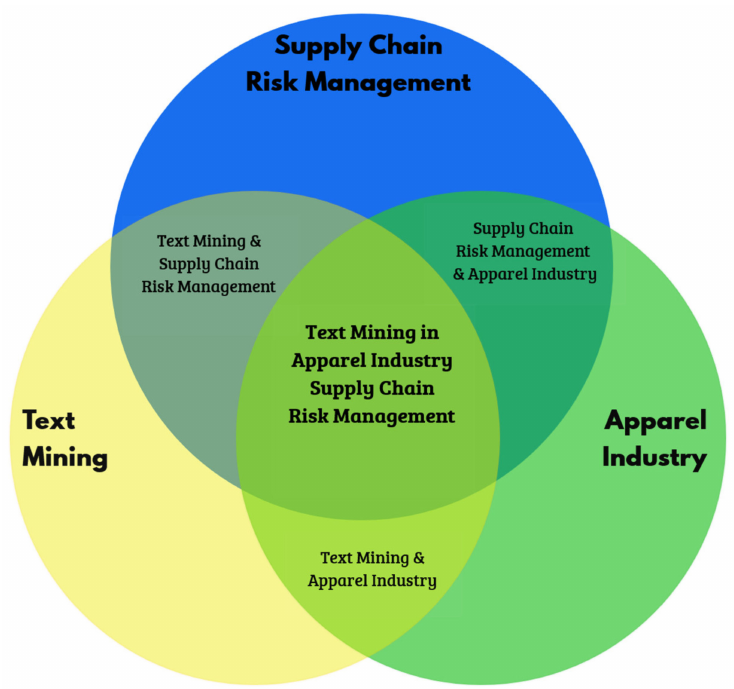
Figure 1. A three-part Venn diagram showing Text Mining, Supply Chain Risk Management and Apparel Industry. Three intersection areas are surveyed in three